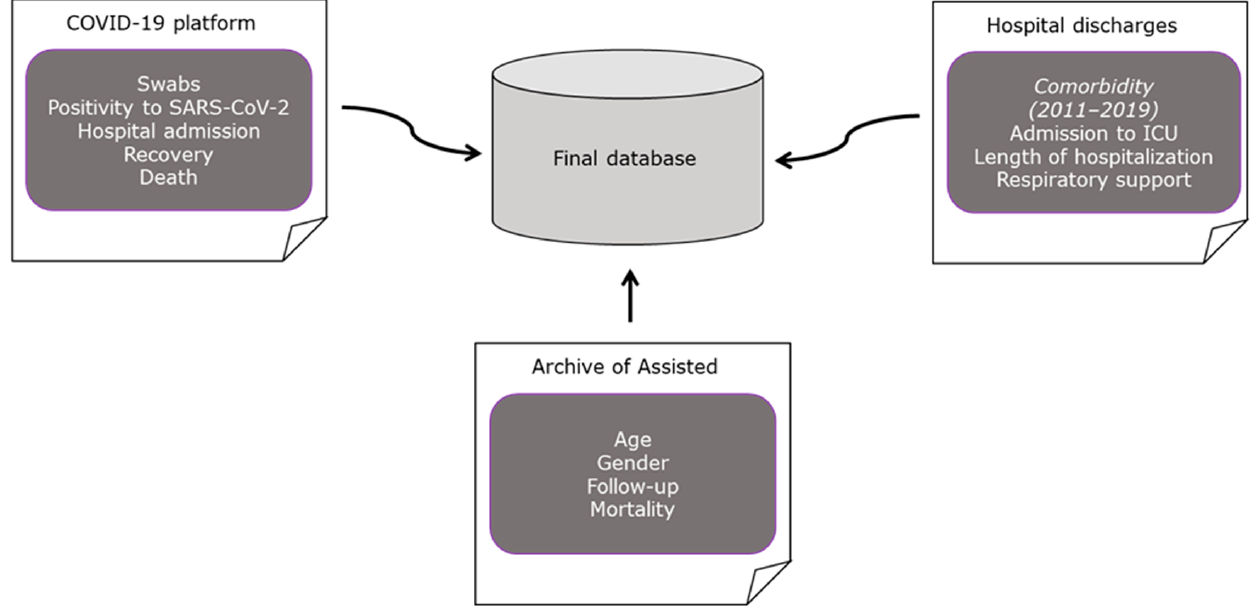
Figure 2. Flow chart on data collection process by record linkage of three different regional-health administrative archives.